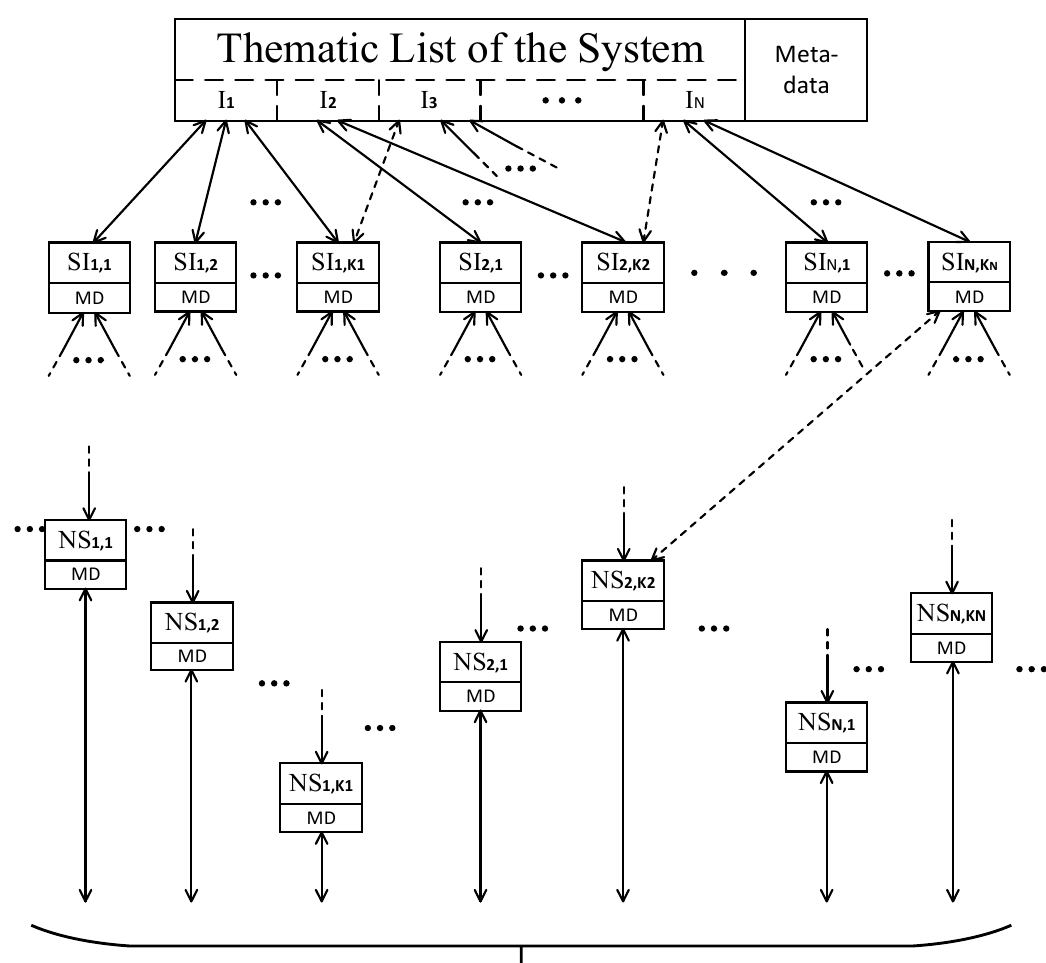
Figure 1. The structure of a thematic decomposition, an analytic explanation of which is presented in Section 5.1, where “MD” stands for “metadata”.